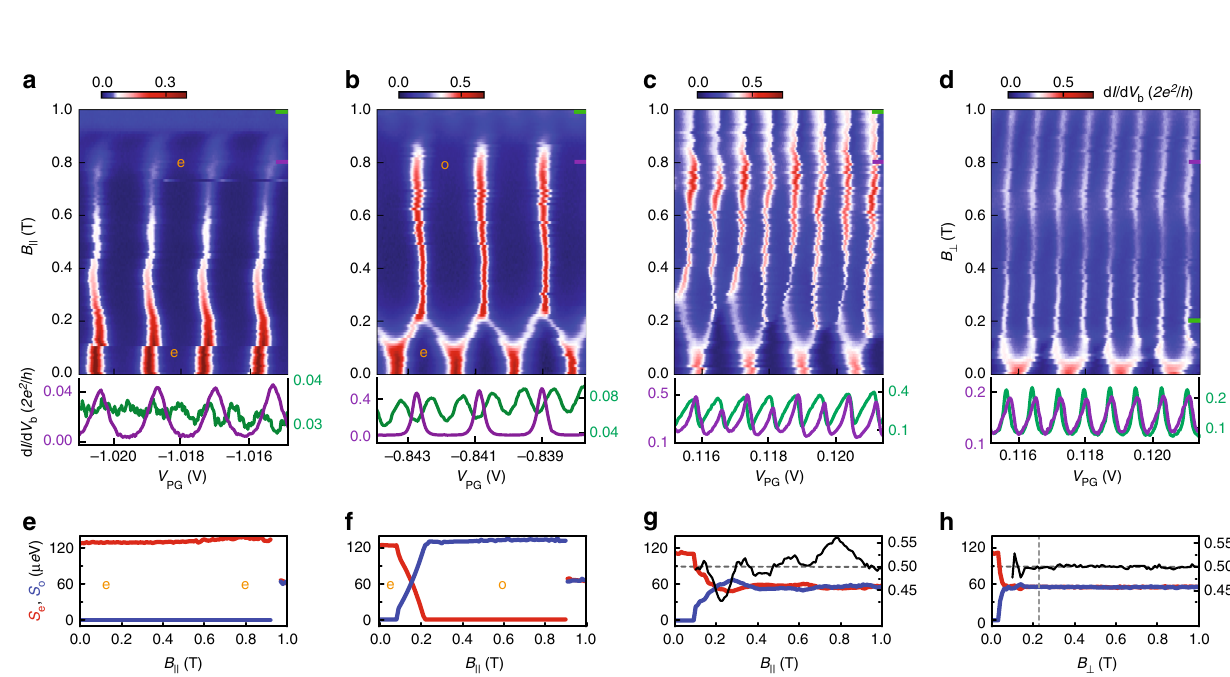
Fig. 1 Hybrid semiconducting – superconducting island and its energy spectrum. a False-colour scanning electron microscope image of the device consisting of an InSb nanowire (green) with an 800 – 900 nm long Al-shell (light-blue) covering the top facet and one side facet. Inset: schematic cross-section at the centre of the plunger gate (PG) indicated by the yellow line. The Si/SiO x substrate contains a global back gate that we keep at zero voltage. The InSb wire is contacted by Cr/Au leads (yellow) and then covered by a 30 nm-thick dielectric layer of SiN x (light-grey). Ti/Au top gates (blue) that wrap around the wire allow for local electrostatic control of the electron density. Two gates are used to induce tunnel barriers (TG) and one plunger gate (PG) controls the electron number on the island. The scale bar indicates 500 nm. b d I /d V b vs. tunnel gate voltage and V b showing 2 e -periodic Coulomb diamonds (one diamond is outlined by yellow dashed lines). The lower panel shows horizontal linecuts with 2 e -periodic Coulomb oscillations at V b = 0 (black trace) and 1 e -periodic oscillations at V b = 150 μ V (red trace). The panel on the right shows a vertical linecut through the Coulomb peak at the degeneracy point (blue trace) and through the centre of the Coulomb diamond (purple trace). Below are four scenarios for the B- dependence of a single Andreev level ( c – f ), the resulting energies as a function of the induced charge, N g ( g – j ), and the Coulomb oscillations ( k – n ). In panels c – f , the grey regions represent the continuum of states above Δ . The coloured traces represent the energy, E 0 , of the lowest-energy subgap state. Panels g – j show the energies of the island with N excess electrons, E ( N g ) = E c ( N g − N ) 2 + p N E 0 , where N g is the gate-induced charge, N is the electron occupancy number, and p N = 0 (1) for N = even (odd). Parabolas for N = even are shown in black, while parabolas for N = odd are shown in colours in correspondence to the colours in the other rows. Crossings in the lowest-energy parabolas correspond to Coulomb peaks as sketched in panels k – n , again with the same colour coding. Labels in the Coulomb valleys between the peaks indicate the GS parity being either even (e) or odd